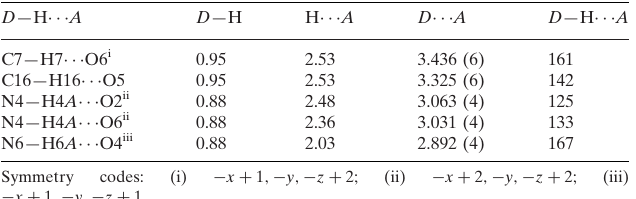
Hydrogen-bond geometry (A˚ , (cid:2)